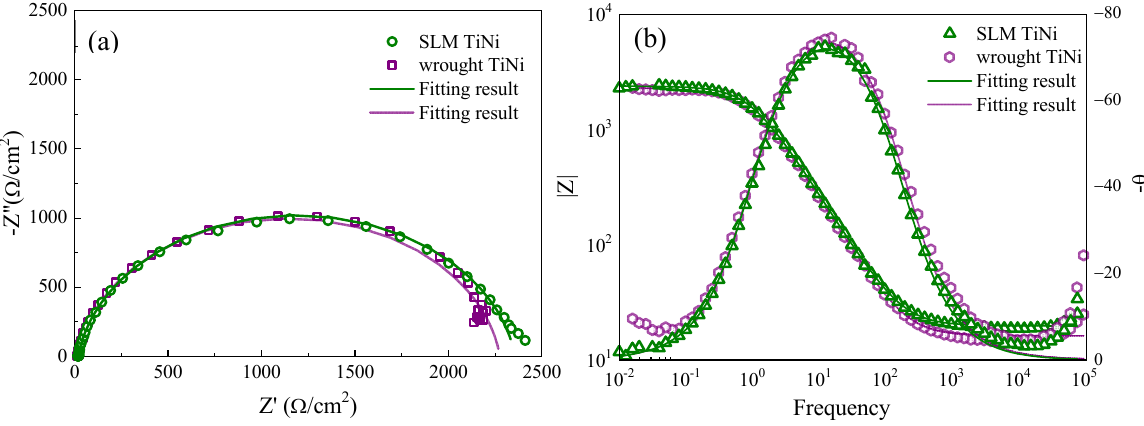
Figure 5. EIS of SLM and wrought TiNi samples at ASS with a pH value of 4 and 0.5%F − ; ( a ) Nyquist; ( b ) Bode.